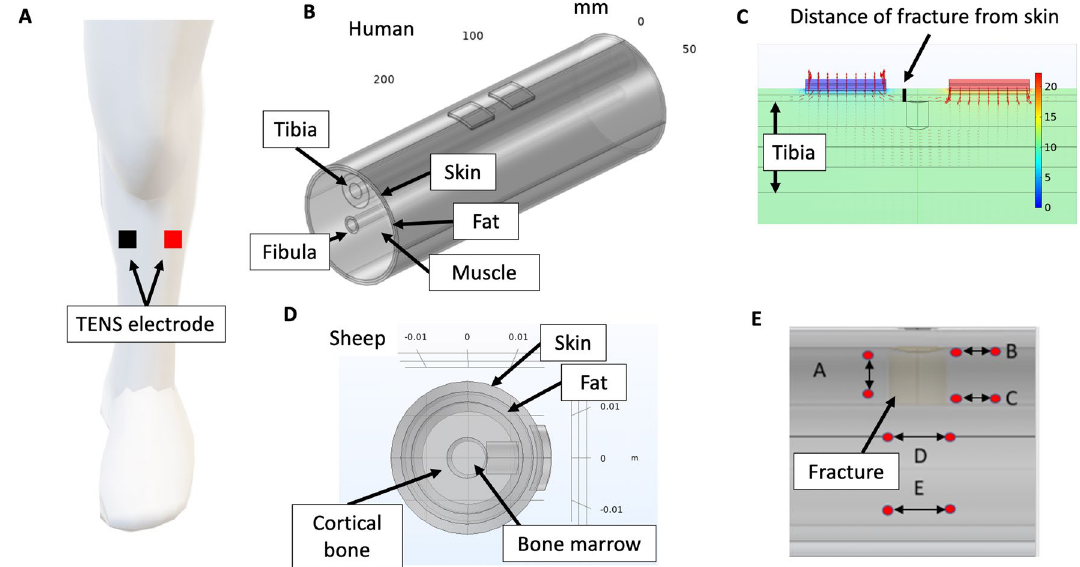
Figure 2. EBGS computational FEM modeling in humans and sheep. ( a ) EBGS electrodes deployed noninvasively (capacitive coupling) for tibial fracture. ( b ) 5-layer computational FEM model of human tibial defect with noninvasive EBGS electrodes patches as shown in ( a ). FEM model includes tibia and fibula bone. ( c ) Electric potential solution of FEM model in ( b ) showing rapid drop off in electric potential from stimulation electrodes to bone defect, even at a short distance without excess adipose tissue. ( d ) FEM model of sheep metatarsus defect with noninvasive EBGS electrodes patches. ( e ) Electric potential measurement points around bone fracture defect. Measurements of electric potentials were taken at five representative points ( A – E ) as the critical field direction required for bone healing has not been established in literature to